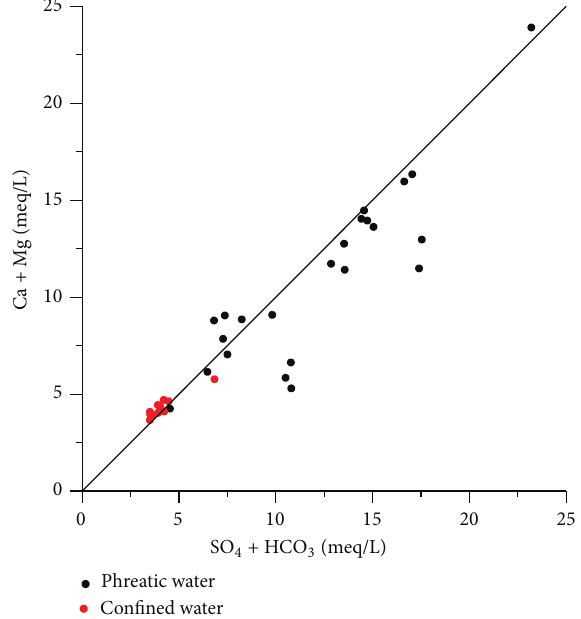
Figure 4: Scatter plot for SO 4 + HCO 3 versus Ca + Mg.